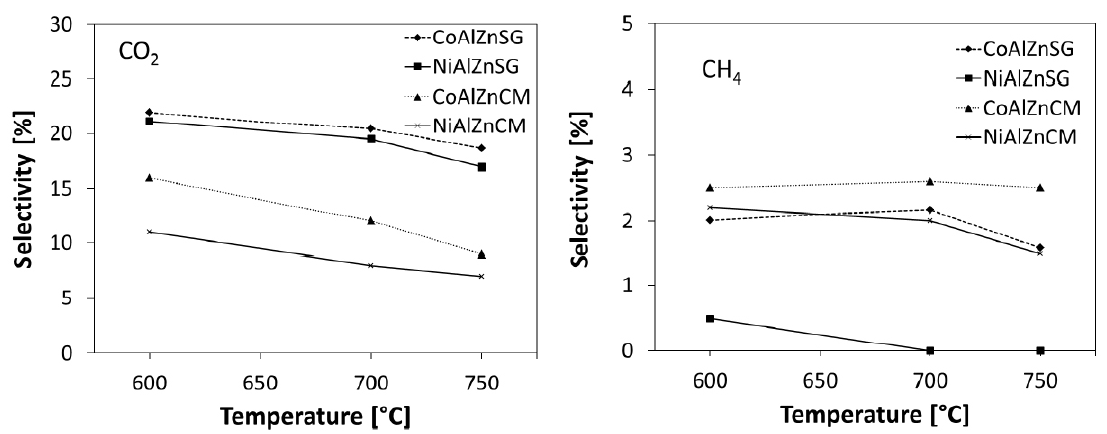
Figure 6. Selectivity of ethanol partial oxidation to CO